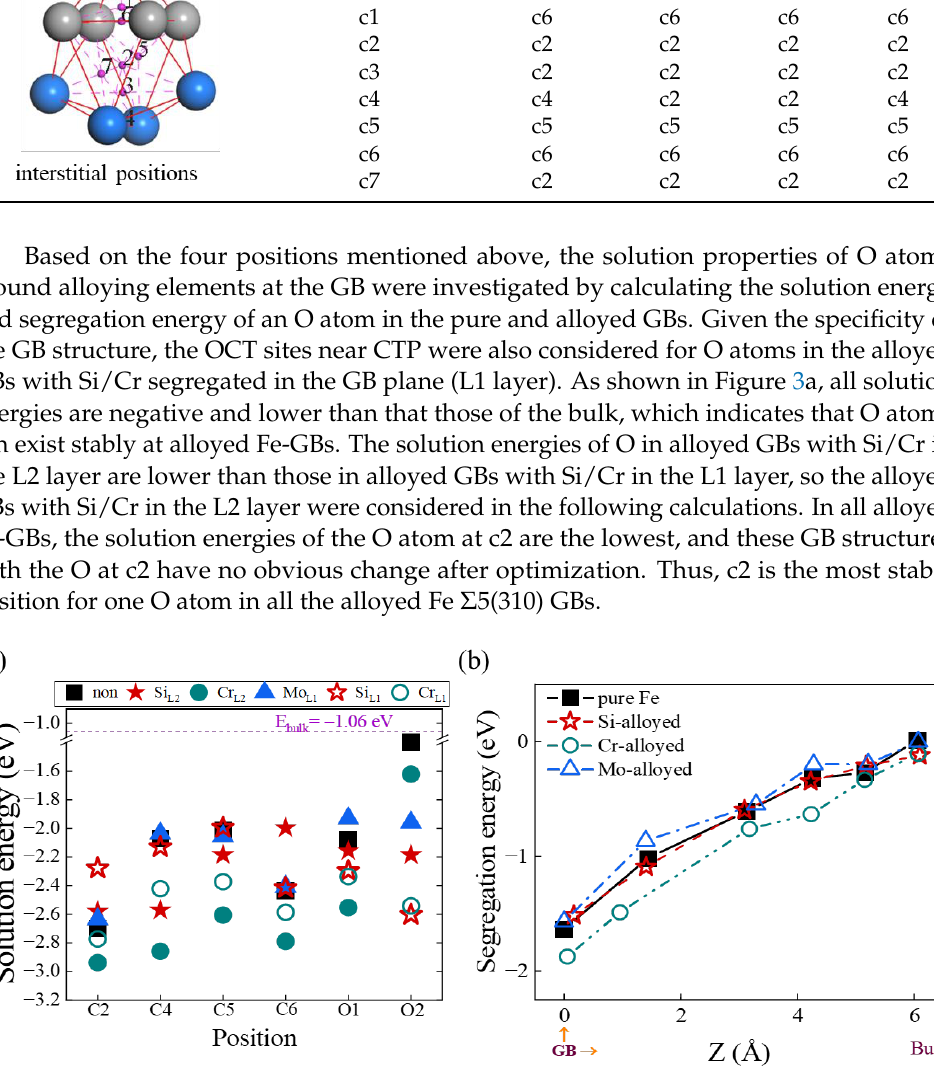
Figure 3. ( a ) Solution energies of O atoms at various stable CTP positions of alloyed Fe-GBs. The black squares represent a pure Fe-GB, the red stars, the cyan spheres and the blue triangles represent Fe-GBs containing Si, Cr and Mo, respectively. Solid symbols indicate Si and Cr in the L2 layer and hollow indicates Si and Cr in the L1 layer. ( b ) The segregation energies of O atoms vary with the distance from the crystal interface. Solid black squares indicate the pure Fe-GB, red hollow stars, cyan hollow spheres and blue hollow triangles indicate Fe-GBs with alloying elements Si, Cr and Mo,